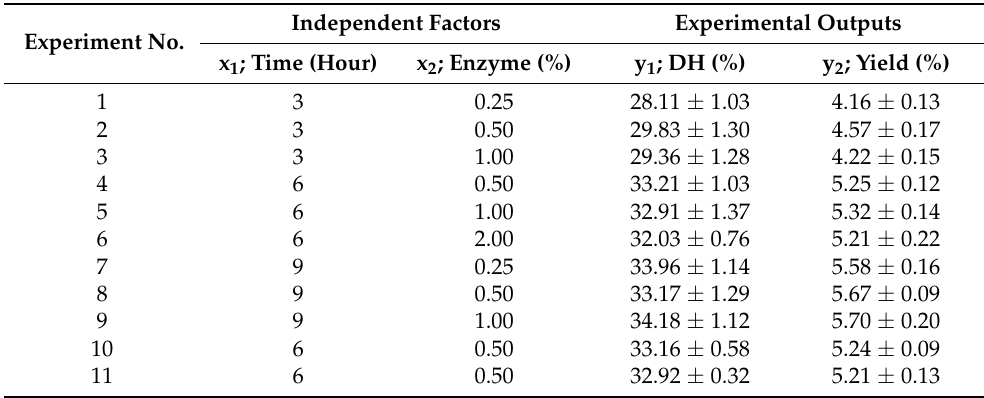
Table 1. The experimental design and experimental outputs of the independent factors for the degree of hydrolysate and yield produced from Lingzhi